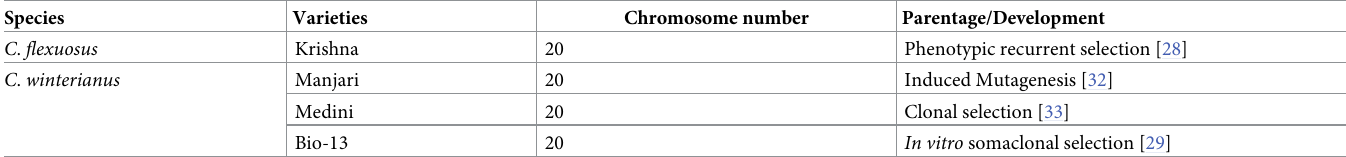
Table 2. Chromosome number and parentage of Cymbopogon species used in the present study.